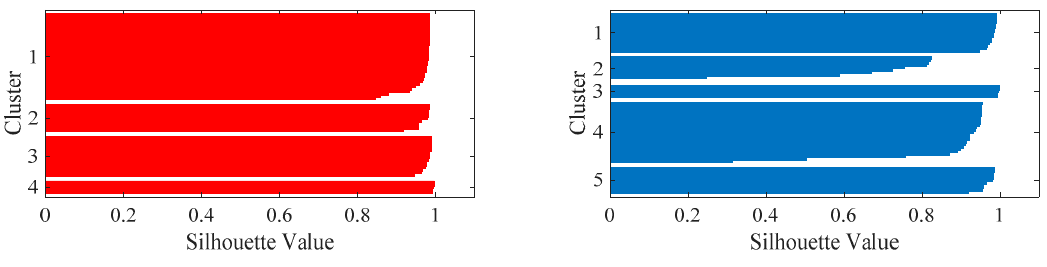
Figure 9. Silhouette value of different cluster number.